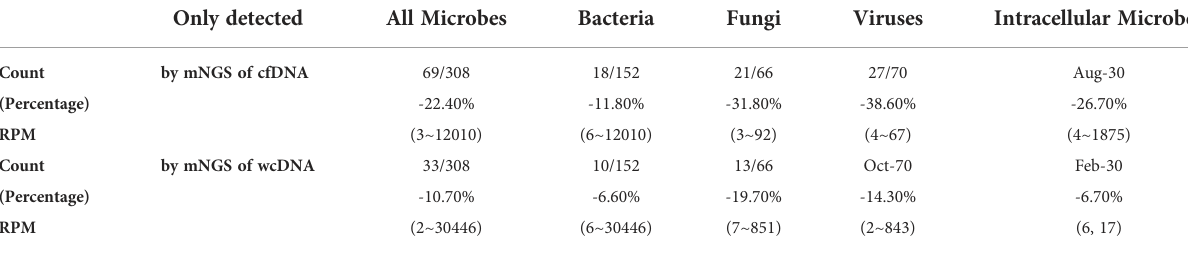
TABLE 3 Statistics of microbes only detected by mNGS of cfDNA or wcDNA.